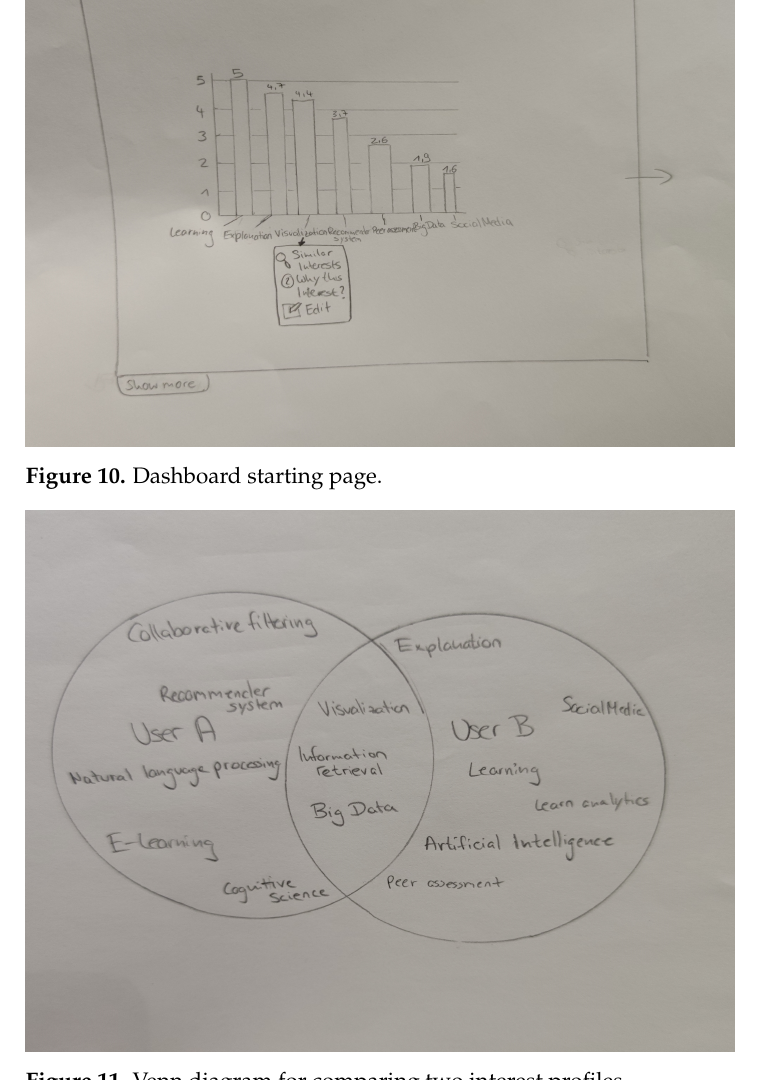
Figure 11. Venn diagram for comparing two interest